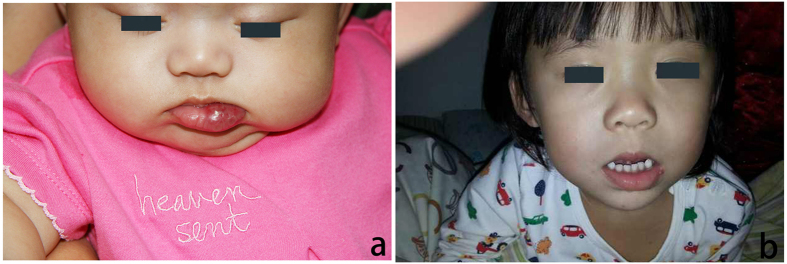
(a) An 8-month-old female patient with a hemangioma located on the lip. (b) The same patient seen at 22 months following intralesional pingyangmycin injections. Note that the major extent of the lesion has disappeared.